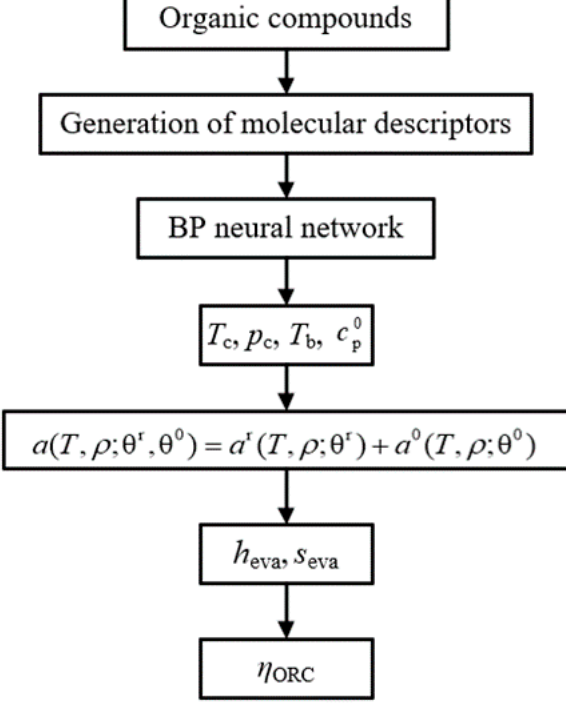
Figure 4. Flow chart of “QSPR+WFPM” coupling model.